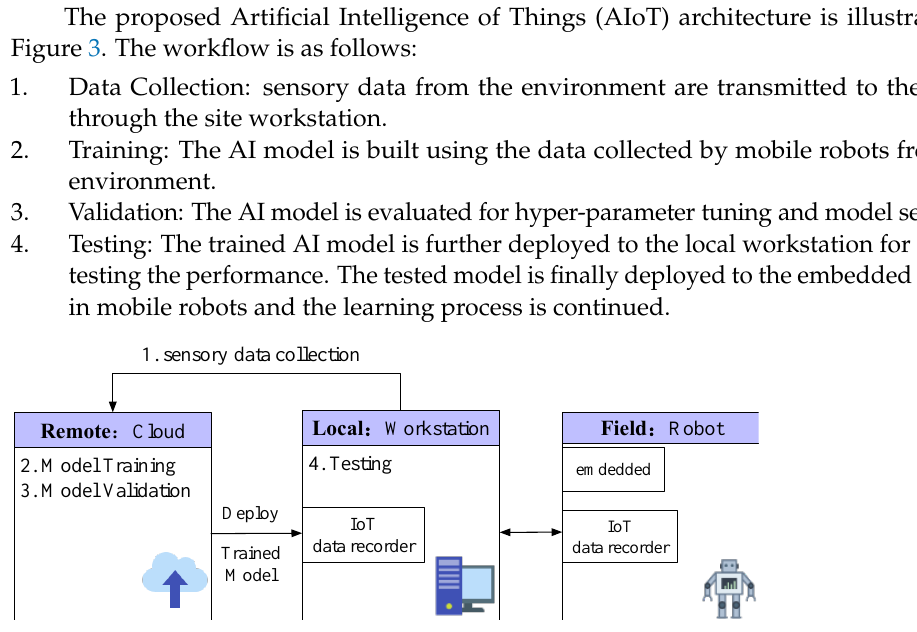
Figure 2. System: Remote swarm AI and local robotic behavior control.